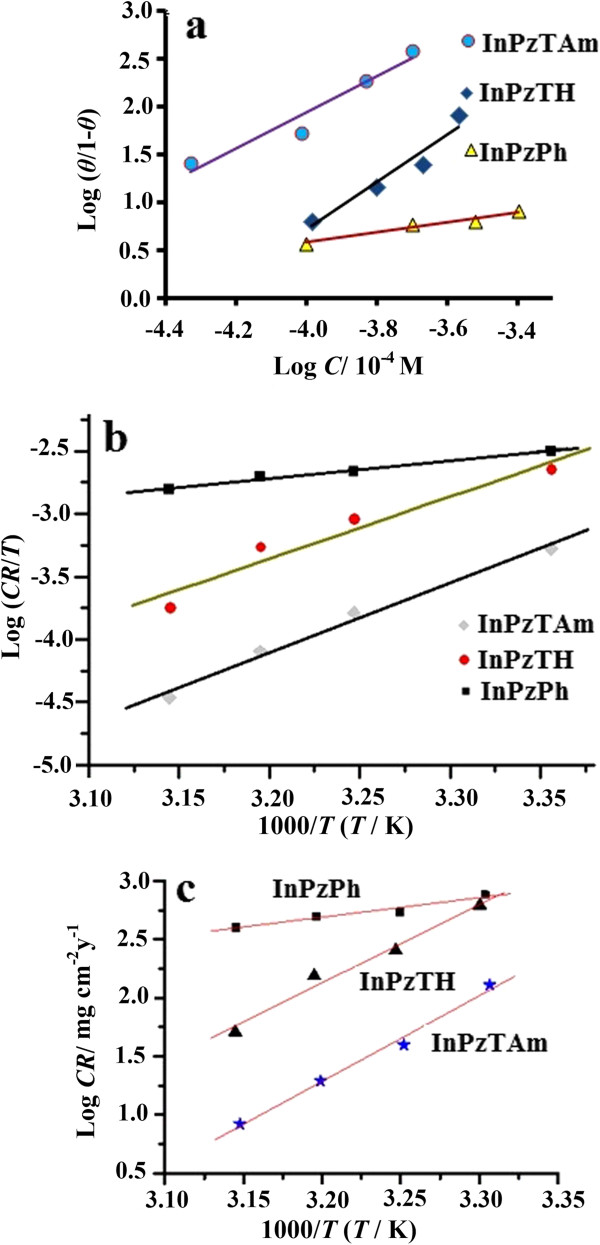
Adsorption isotherm plots in various amounts of pyrazolylindolenine compounds in 1 M HCl media a); log θ/θ-1 vs. log C, b) logCR/T vs. (1000/T), c); logCR vs. (1000/T).